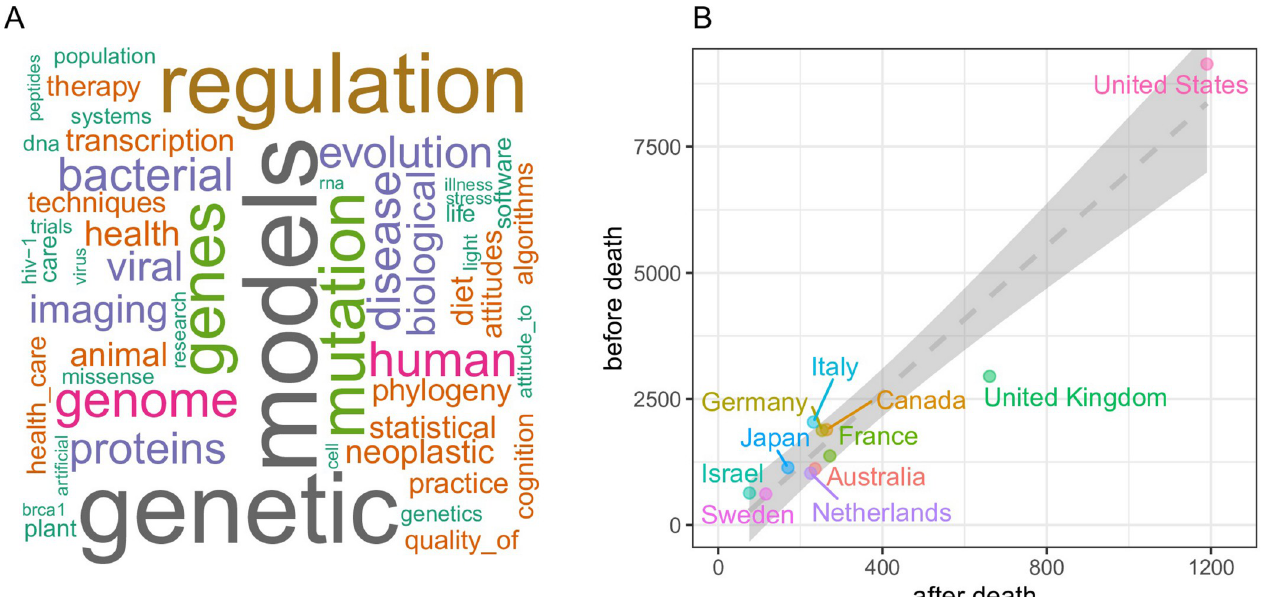
Fig 5. Word cloud representations of (A) topic MeSH terms and (B) country affiliations of first authors of deceased publications. (A) The word cloud image is a visual representation of word frequency derived from analysis of the full text of the deceased author publications in the database. The more often the word appears within the text the larger it’s appearance in the image. (B) Plot of first author country affiliations of publications containing a deceased author comparing after death publications on the X-axis versus before death publications Y-axis. Only the top 11 countries are depicted.